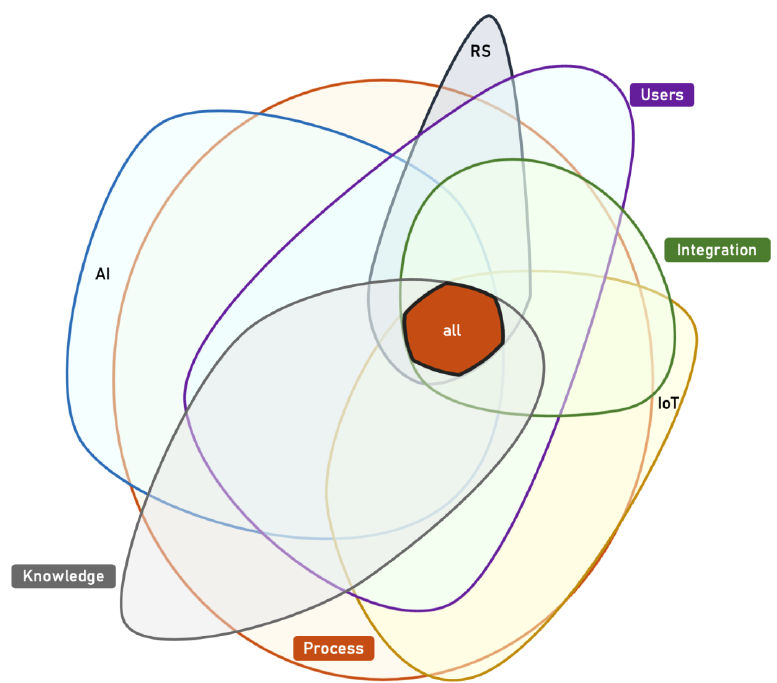
Figure 1. Research themes (keywords) and disruptive technologies presence for the papers in Table 4. Performance is overarching, therefore not depicted in the figure.